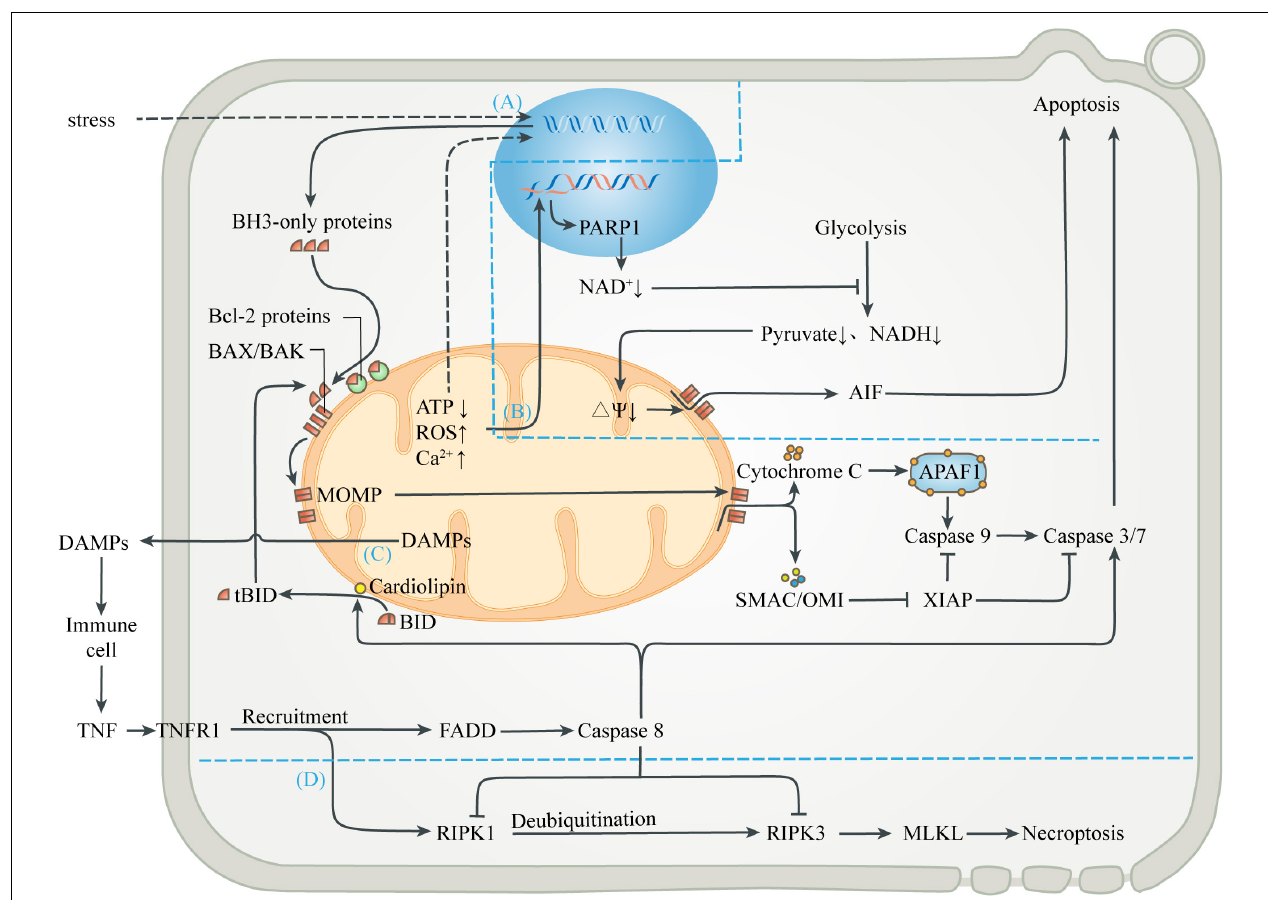
FIGURE 3 | Mitochondria-mediated regulated cell death. (A) Mitochondrial apoptosis. Signals from mitochondrial injury stimulate the synthesis of BH3-only proteins, which can activate BAX/BAK on mitochondrial membrane to cause MOMP when the isolation of anti-apoptotic Bcl-2 proteins is exceeded. Cytochrome C interacts with APAF-1 to form the heptameric apoptosome, which initiates the caspase cascade to execute apoptosis. Activation of caspases can be inhibited by XIAP, which in turn is blocked by SMAC and OMI. Activated caspases 3 and 7 cleave cell components, including nuclear DNA and ultimately cause apoptosis. (B) Parthanatos. Mitochondrial abnormalities can also directly lead to nuclear DNA damage, which activates PARP1 to deplete NAD + , thereby inhibiting glycolytic production of pyruvate and NADH. In the absence of substrates, mitochondrial depolarization triggers the release of AIF, leading to parthanatos. (C) Exogenous apoptosis. The release of contents during mitochondrial injury activates immune cells and leads to the release of TNF. After TNF binds to TNFR1, FADD is recruited and caspase 8 is activated, directly activating caspase 3/7 to induce apoptosis. Caspase 8 can also activate BID to enter the mitochondrial apoptosis pathway. In this process, cardiolipin provides an anchor and an activating platform for caspase-8 and BID at the mitochondrial membrane surface. (D) Necroptosis. RIPK1 is also recruited after the binding of TNF and TNFR1, but recruited RIPK1 is usually ubiquitinated and inactivated. ROS, acidosis and other factors can lead to deubiquitination of RIPK1, which in turn leads to phosphorylation of RIPK3 and MLKL, leading to interruption of membrane continuity and necrosis. However, in most cases, simultaneous activation of caspase 8 can lyse RIPK1 and RIPK3 and truncate the